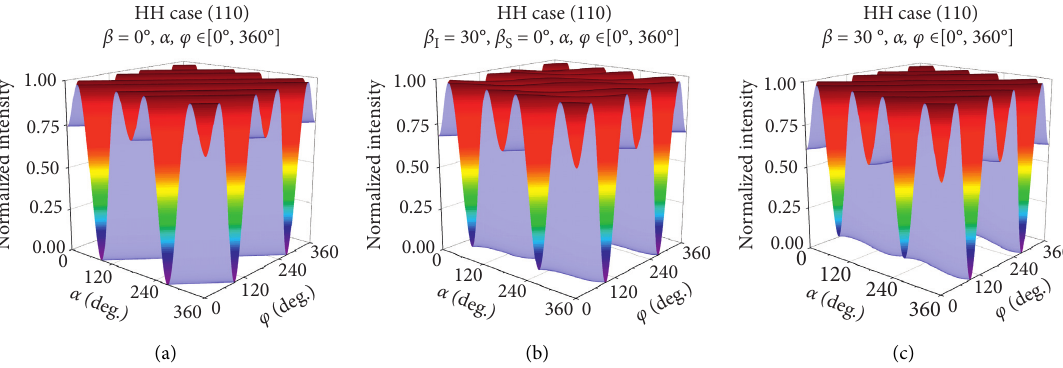
Figure 14: Intensity distributions of Raman modes in the HV case under off-axis scattering ( β directions φ and sample rotation angles: (a) α � 0 ° and (b) α � 30 ° .